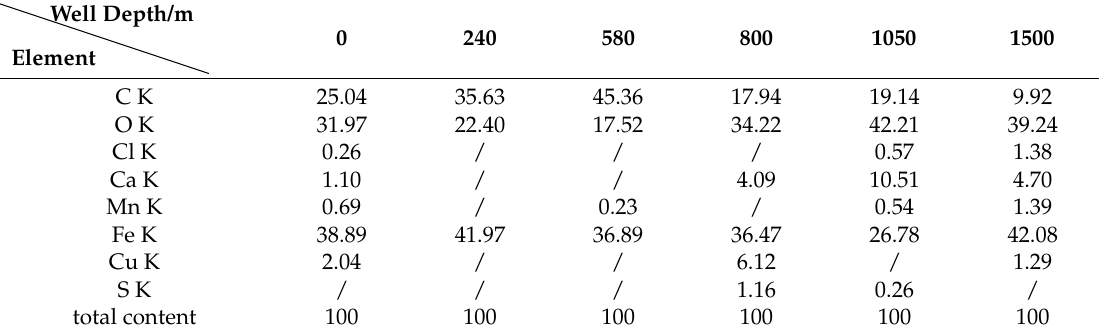
Table 4. EDS results for the surfaces of J55 steel after corrosion (%).